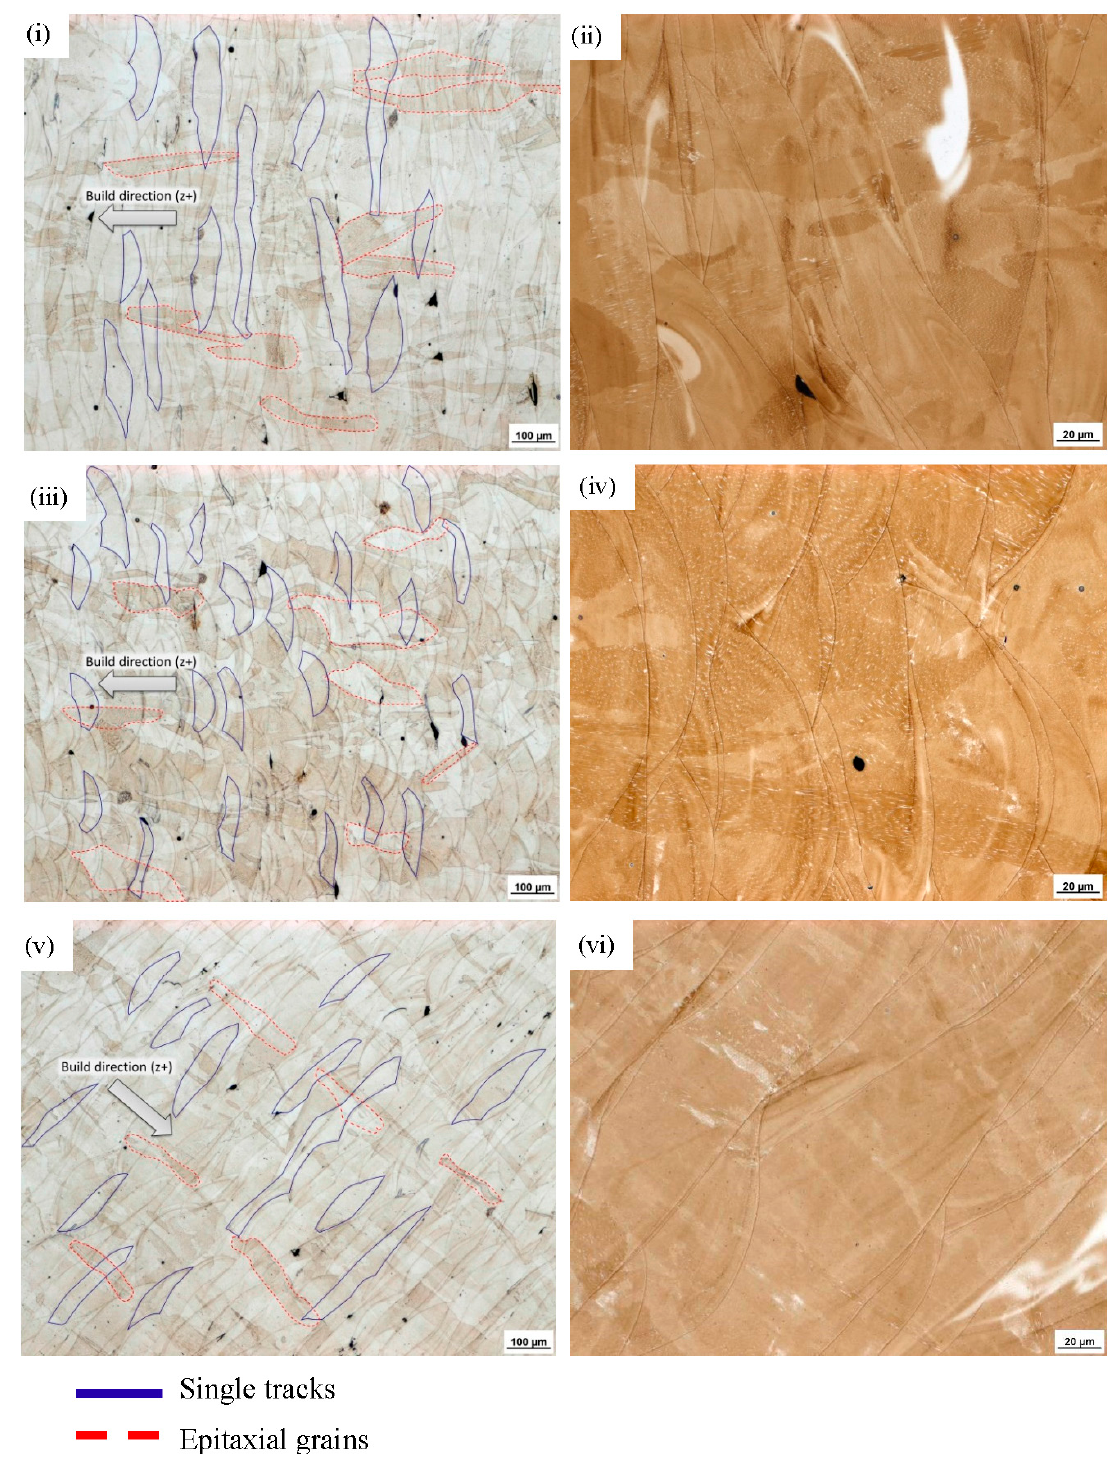
Figure 10. Microstructure of 1.4404, taken from the cross-section of the tensile samples of ( i , ii ) configuration (a); ( iii , iv ) configuration (b); and ( v , vi ) configuration (d). Left-hand column: lower resolution; right-hand column: higher resolution.